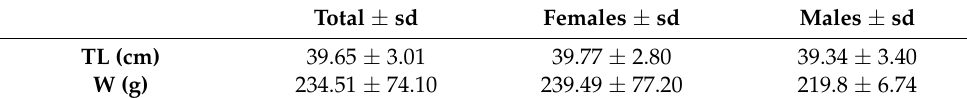
Figure 3. Frequency histogram of the numbers of specimens collected by month and by sex.